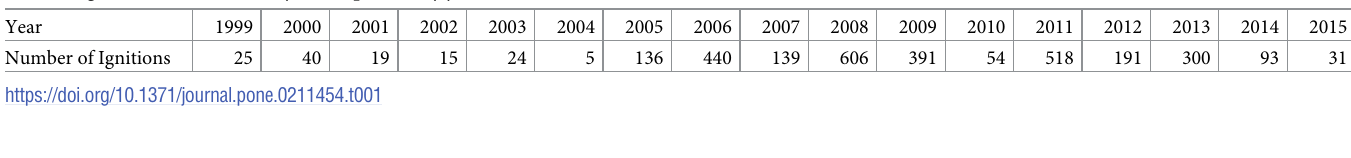
Table 1. Ignitions within the study area separated by